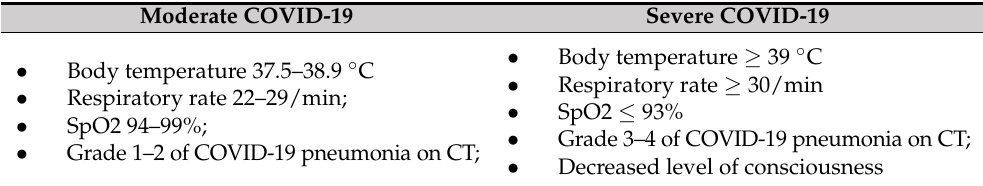
Table 9. Criteria for the moderate and severe courses of COVID-19. Moderate